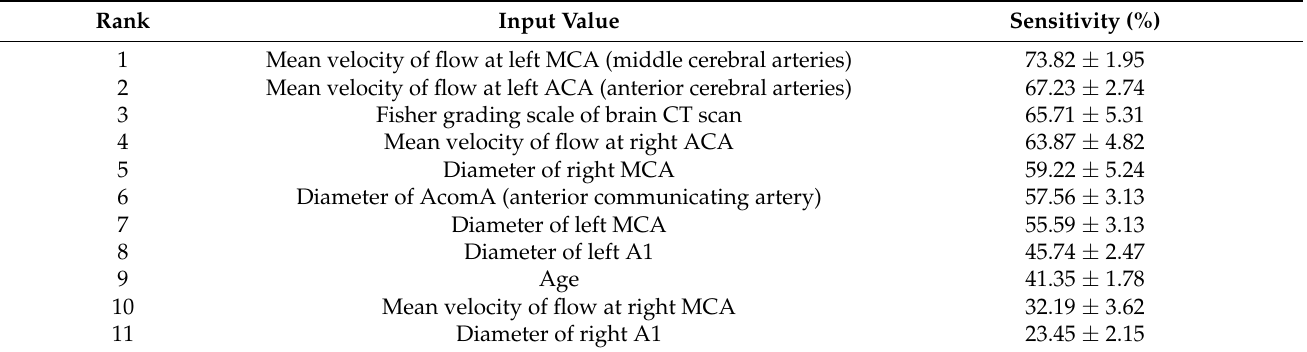
Table 3. Ranked output of the sensitivity